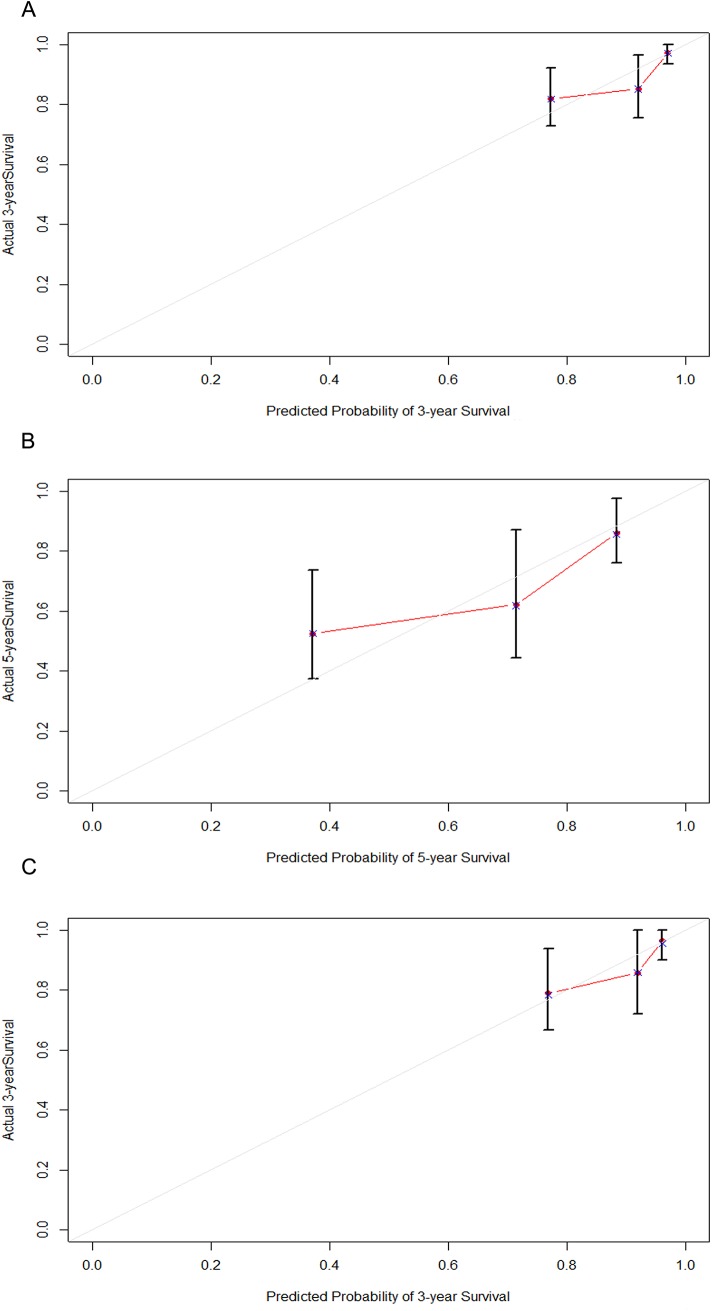
The calibration curve for predicting IgAN patients’ relapse nomogram.(A) at 3 years in the primary cohort and (B) at 5 years in the primary cohort and (C) at 3 years in the validation cohort. Nomogram-predicted probability of overall IgAN relapse is plotted on the x-axis; actual overall IgAN relapse is plotted on the y-axis.